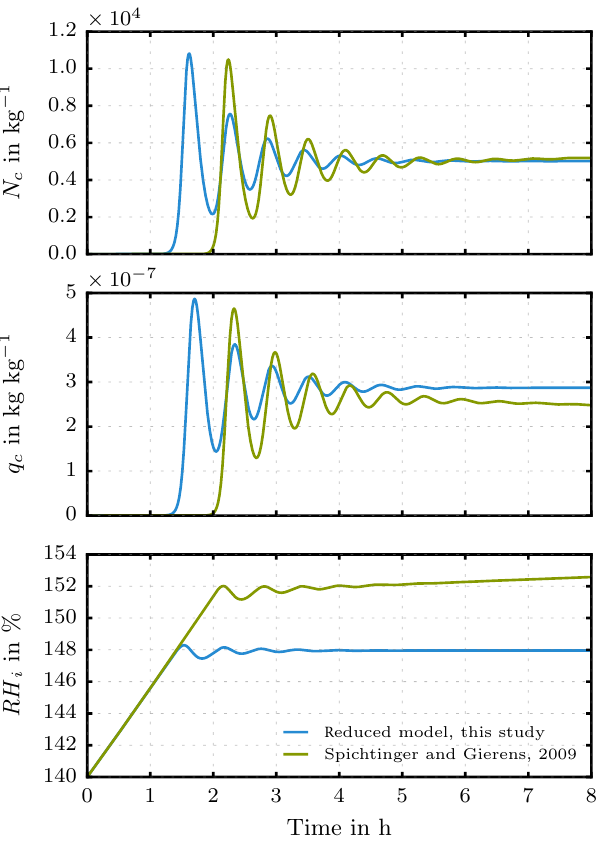
Figure 14. Limit cycle case (state 2): comparison between reduced model (this study) and the complex box model by Spichtinger and Gierens (2009). Updraught w = 0 . 02ms − 1 , temperature in the re- duced model and start temperature of the complex model is T =